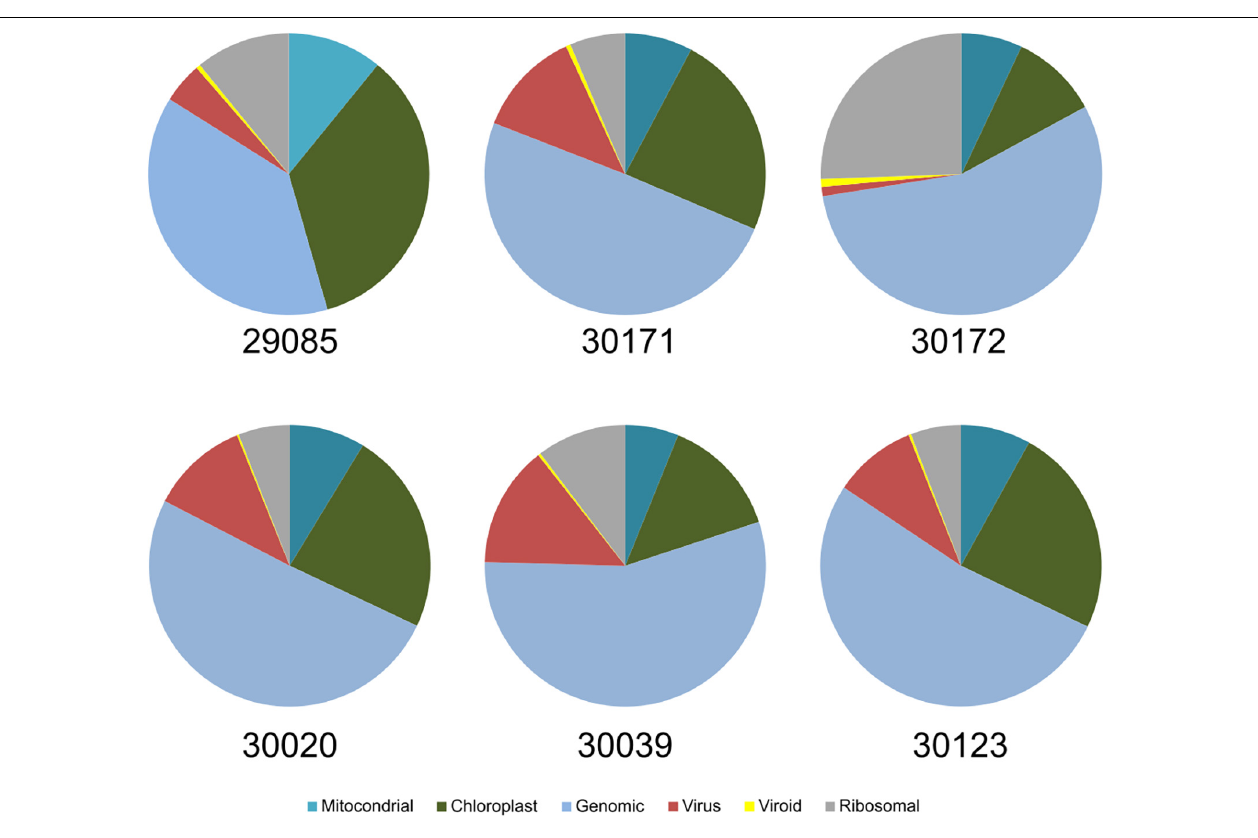
FIGURE 2 | Ontology of the contigs obtained from the samples of batch #1 after BLAST analysis. Virus and viroid contigs represent between 2 and 15% of the total contigs derived from the HTS of